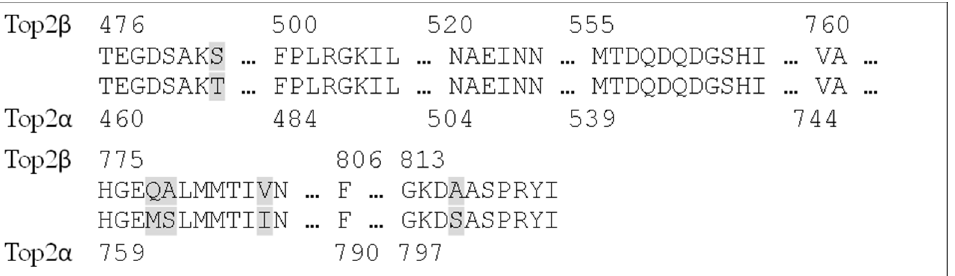
Fig. 2. Sequence alignment of Top2 a and Top2 b ligand binding pocket residues. Non-conserved residues are highlighted.